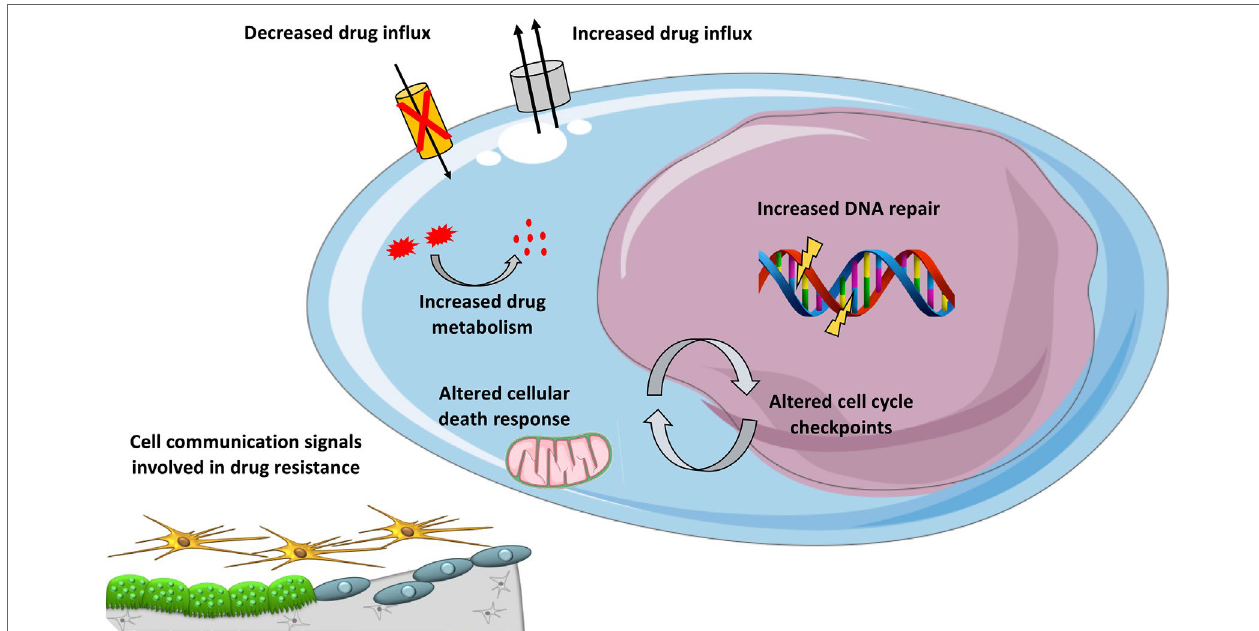
FIGURE 1 | Mechanisms involved in DNA-damaging drug resistance in MM. Overview of mechanisms contributing to resistance to DNA-damaging agents in MM, including cellular extrusion of the drugs by ATP-dependent pumps, decreased drug influx, increased drug inactivation by metabolism, inactivation of apoptotic pathways, enhanced DNA repair, and altered cell cycle checkpoints and cell communication signals provided by the